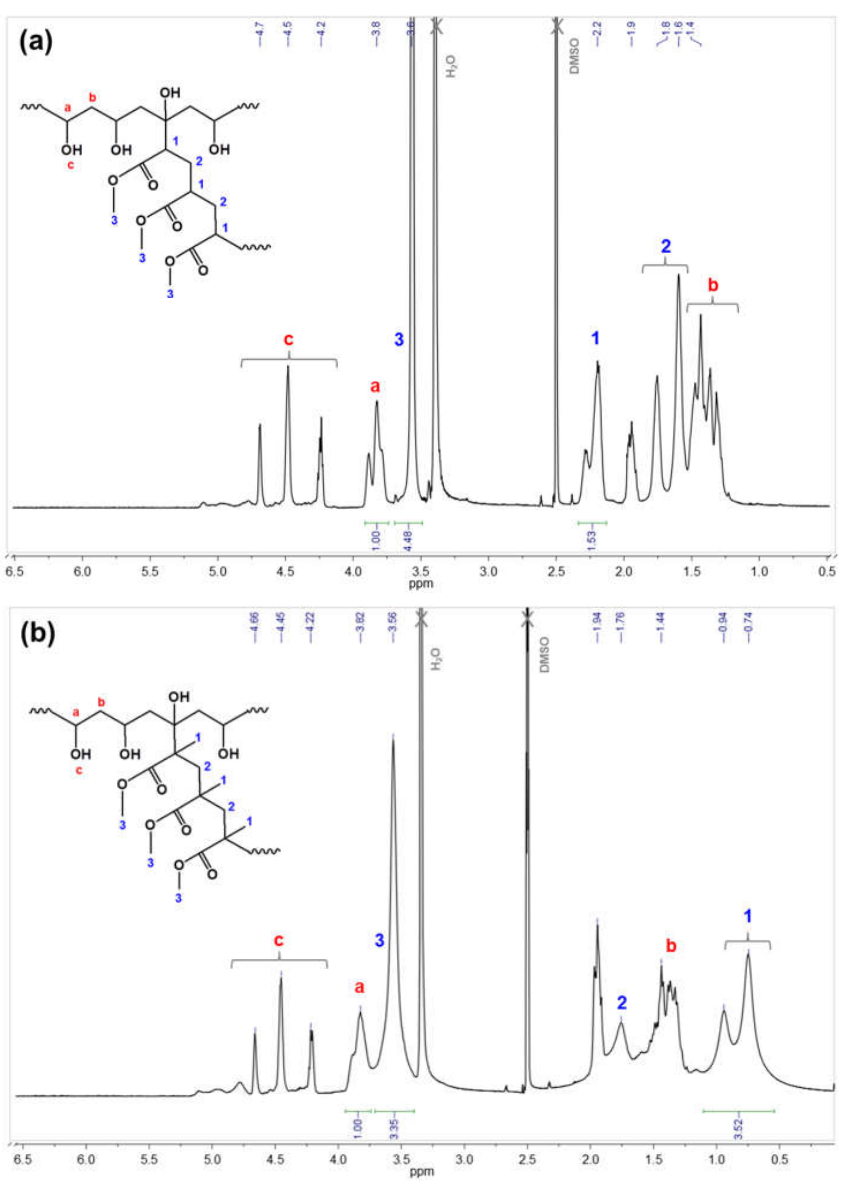
Figure 2. 1 H NMR spectra (600 MHz; solvent DMSO-d 6 ) of ( a ) CP1; and ( b ) CP5.